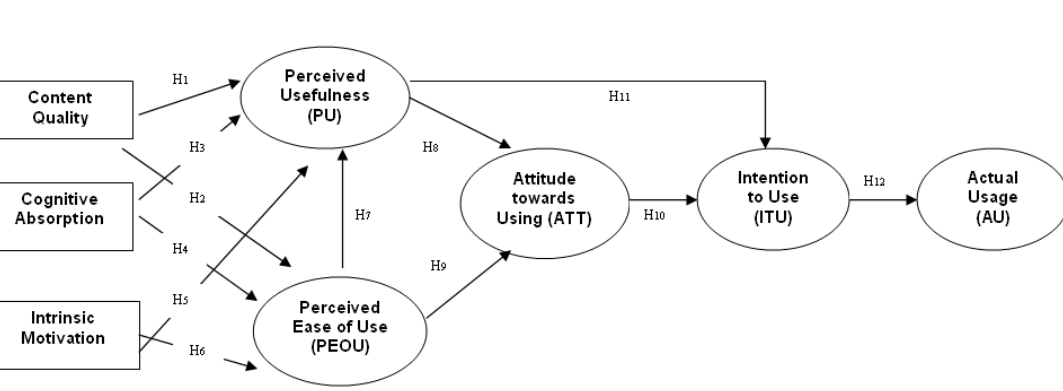
Figure 3. SCORM-compliant learning object acceptance model